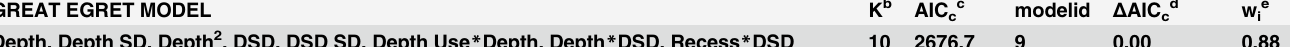
Table 3. Ranking of candidate models describing variables influencing daily mean days since drydown (DSD) use of Great Egrets, White Ibises, and Wood Storks in the Florida Everglades (Proc Mixed). GREAT EGRET MODEL